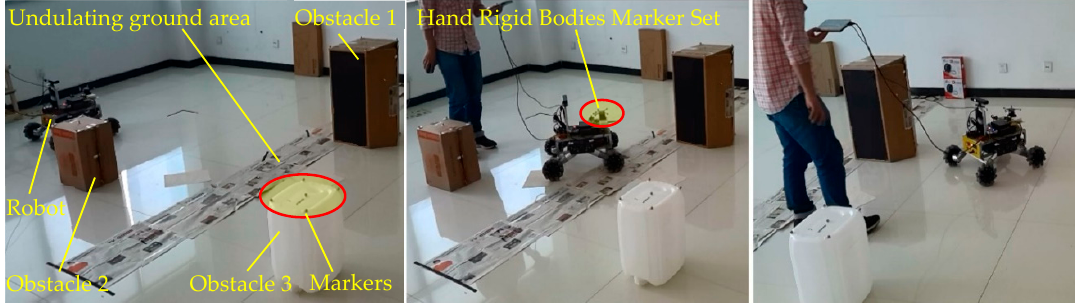
Figure 40. Navigation test of the robot prototype in the physical environment: ( a ) the robot navigates from the starting point; ( b ) the robot moves through the undulating terrain; ( c ) the robot reaches the target point.